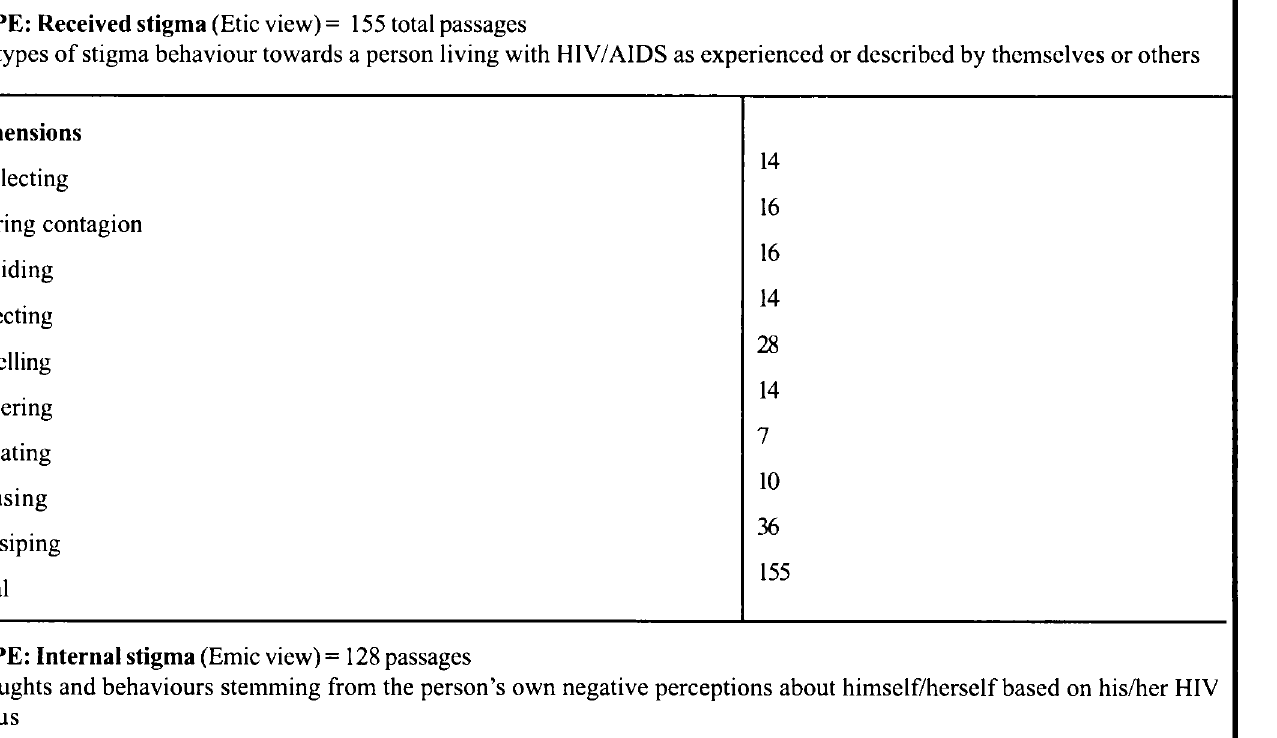
Table 3: Types and dimensions of HIV/AIDS stigma TYPES AND DIMENSIONS OF HIV/AIDS